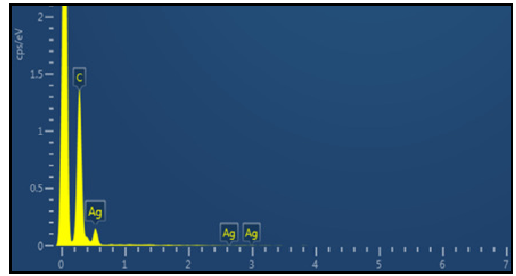
Fig. 10. EDX spectrum result of (0.4% AgNO3/Nylon